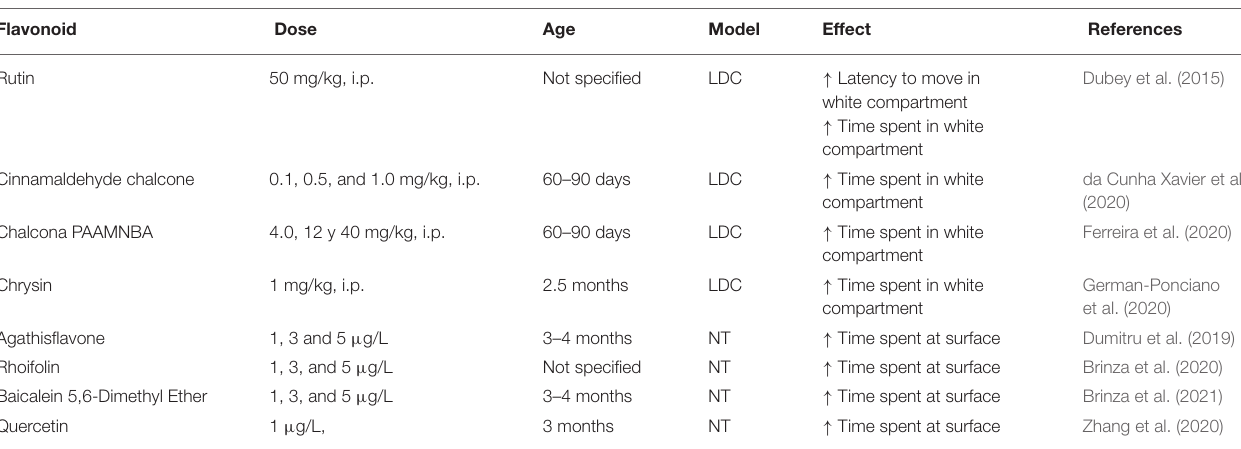
TABLE 2 | Behavioral effects of flavonoids in adult